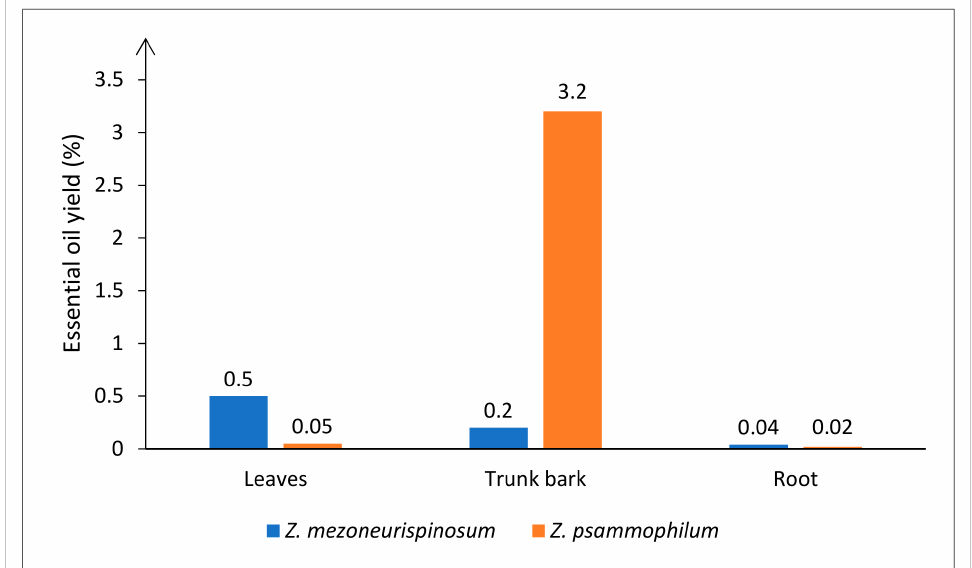
Figure 2. Essential oil hydrodistillation yields (%) from Z. psammophilum and Z. mezoneurispinosum organs. Yields are expressed as g / 100 g of fresh